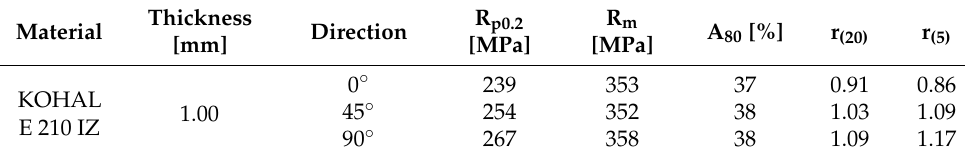
Table 2. Mechanical properties of the evaluated sheets.